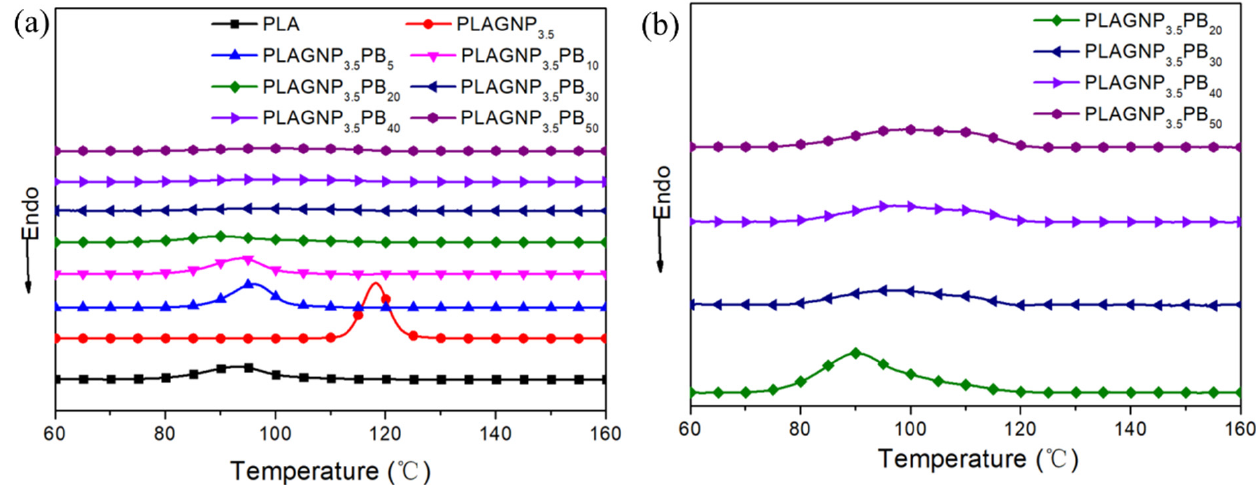
Figure 4. ( a ) DSC curve of PLAGNP 3 . 5 PB y composite and ( b ) the magnification curve diagram. Table 1. Comparison table of the crystallization process of PLAGNP 3 . 5 PB y composite.